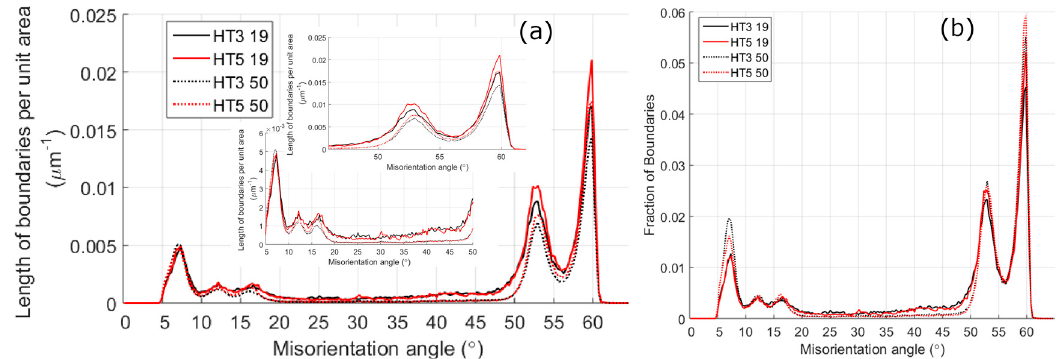
Figure 4. Misorientation angle profiles calculated by MTex for grains with misorientation angles above 5°, for the different samples studied. ( a ) Are the length of boundaries (in µm) per unit area (µm 2 ) (normalised for different map sizes); and ( b ) the fraction of different boundary types.